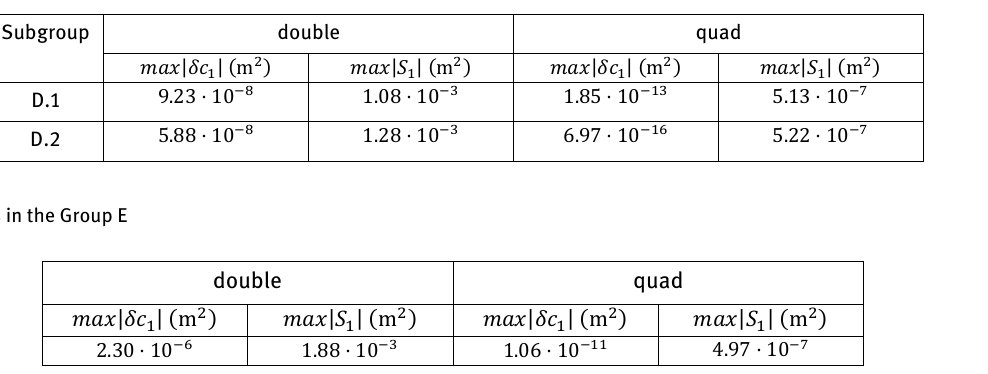
Table 13: Results in the Group D